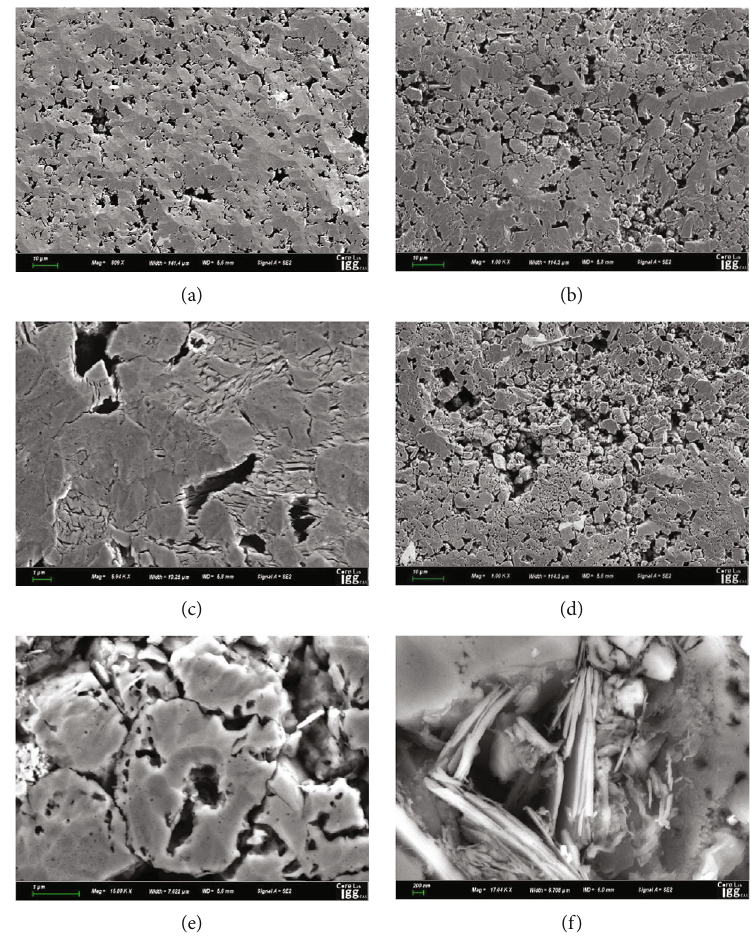
Figure 6: Microscopic pore structure changes before and after the interaction of di ff erent fl uids. (a) Pores of muddy dolomite are increased, and salt minerals migrate (supercritical CO ). (b) Salt minerals are dissolved (distilled water). (c) Clay mineral expansion occurs (distilled 2 water). (d) Pores are dissolved, causing caves (supercritical CO saturated solution). (e) Dolomite particles are dissolved, causing dissolved 2 pores (supercritical CO saturated solution). (f) Clay is released, and particle migration occurs (supercritical CO 2